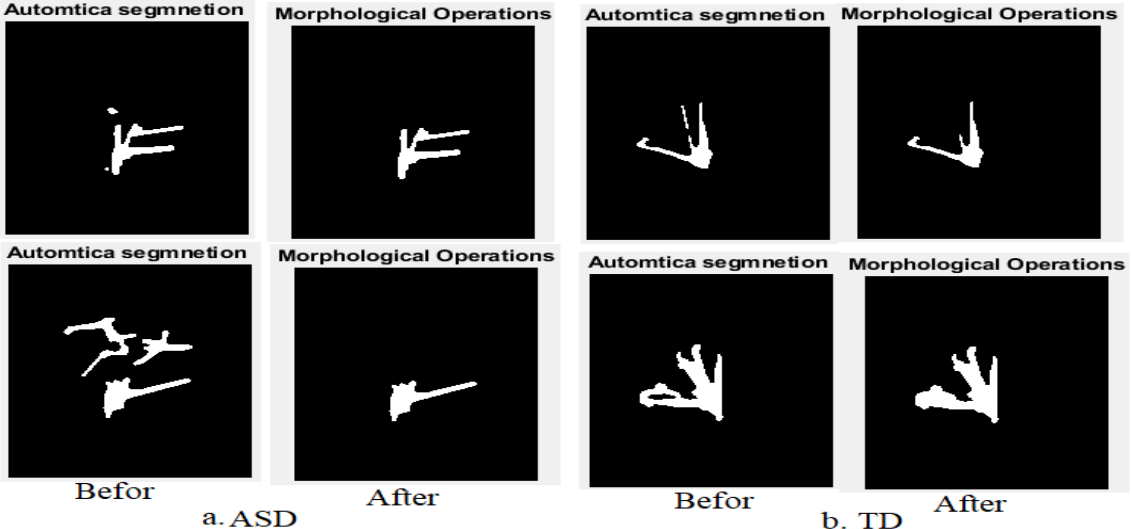
Figure 4. Some images of the dataset before and after the morphological method ( a ) ASD class, ( b ) TD class.